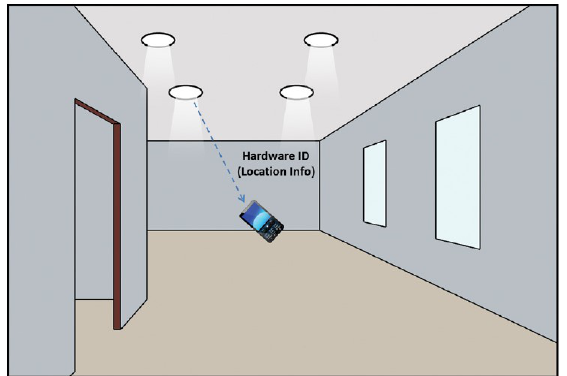
Figure 16. VLC localization system, reproduced with permission from Zhang, Asynchronous indoor positioning system based on visible light communications , published by SPIE Digital Library, Optical Engineering,